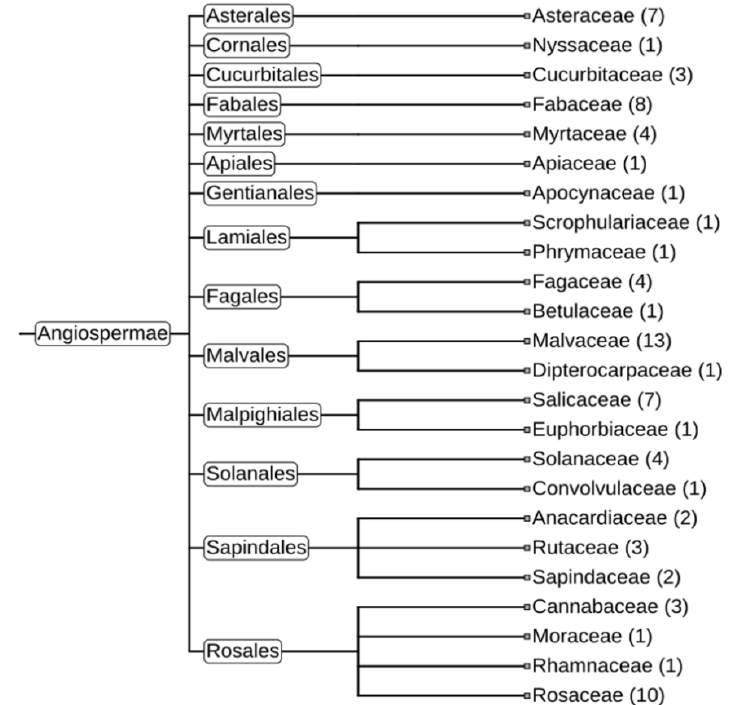
Figure 7. Phylogeny tree of plants containing HadGAG2 homolog proteins (in brackets — number of plant species where HadGAG2 homologs were found). The tree was constructed using iTol [37]. HadGAG2 homolog proteins possess four major protein domains: PF14223 (Copia-